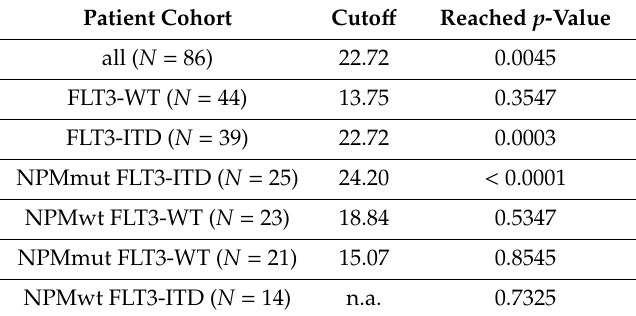
Table 2. Cuto ff values and p-values for survival curves in di ff erent subcohorts.